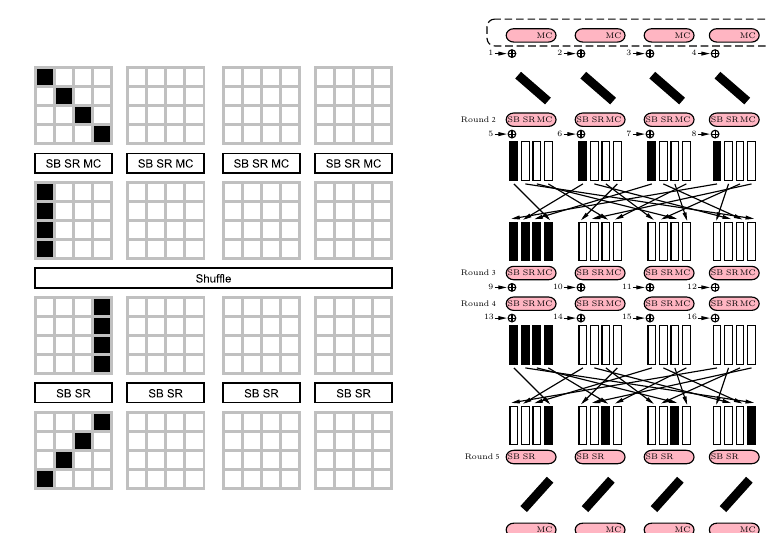
Figure 4: SuperSBox and MegaSBox [BA14] of AESQ . There are 16 SuperSBoxes